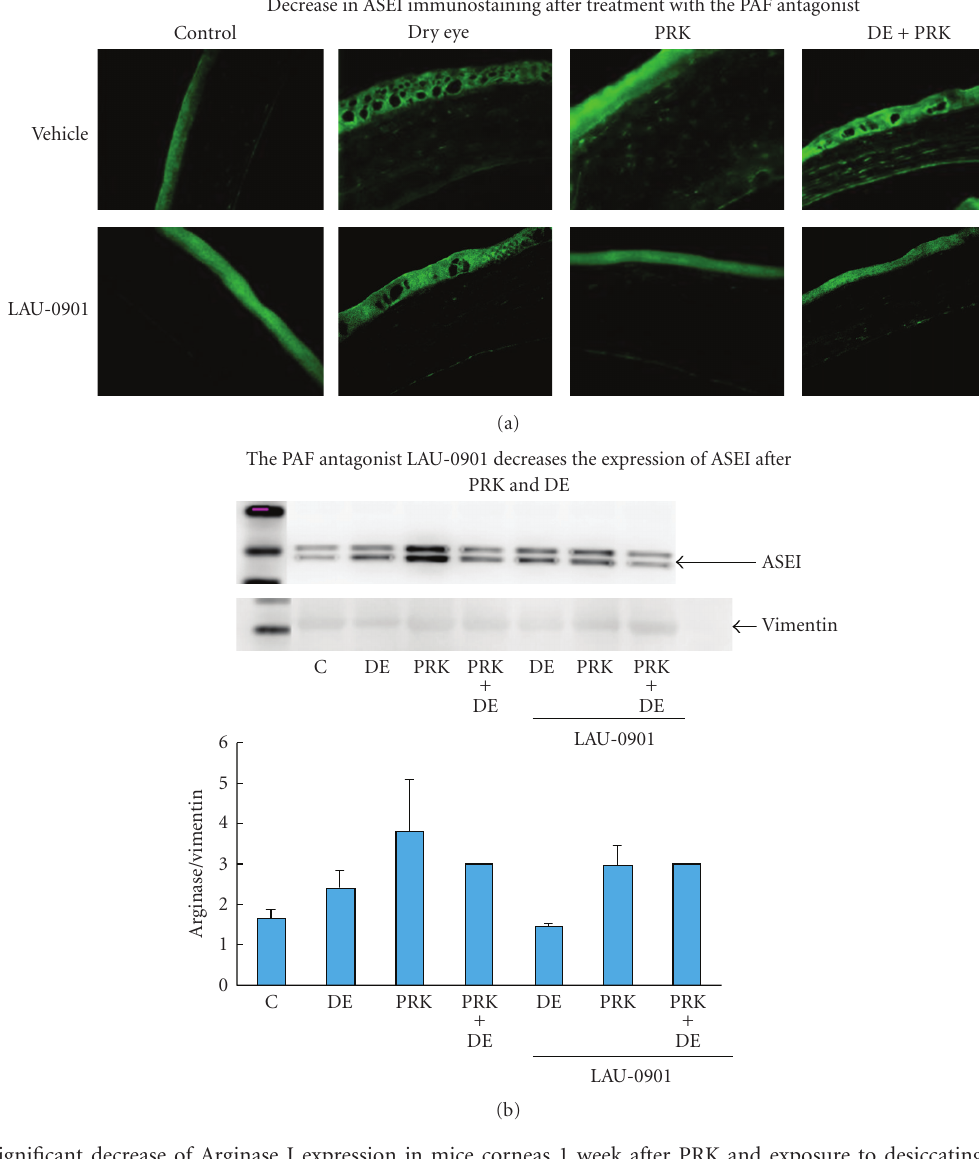
Figure 3: Significant decrease of Arginase I expression in mice corneas 1 week after PRK and exposure to desiccating conditions after treatment with